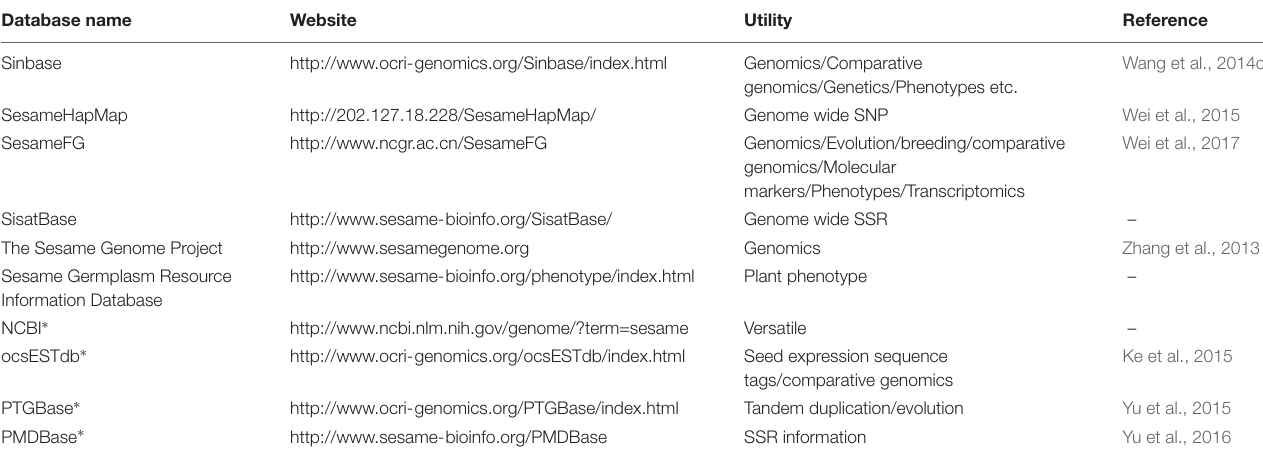
TABLE 4 | List of available online databases for functional genomics in